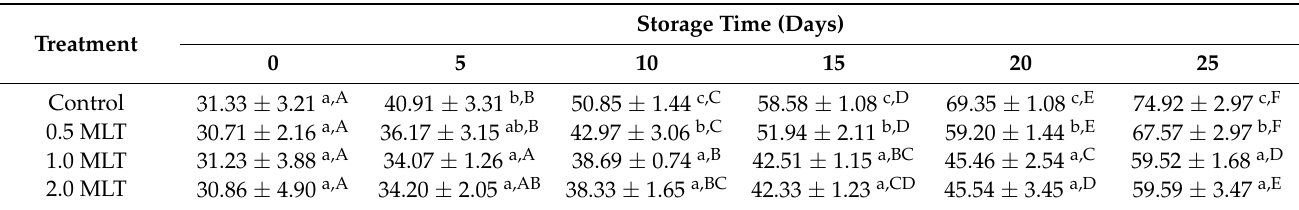
Table 5. Effect of melatonin treatment on lignin content (g/Kg fresh weight) of green asparagus during 25 days of storage at 4 ◦ C and 90% relative